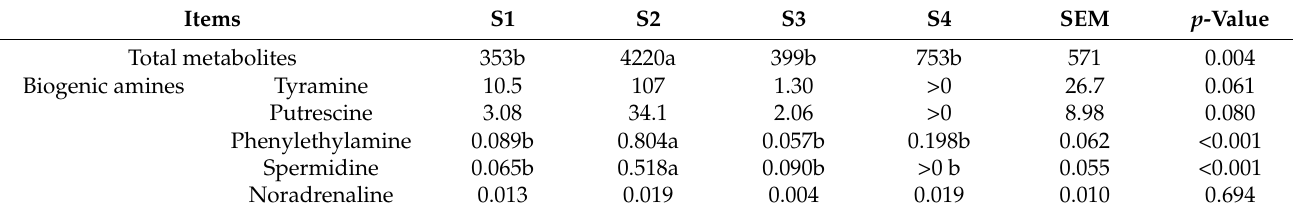
Figure 5. Principal component analysis of the metabolites in whole-plant corn silages (n = 3). S1, silage collected from Erdos; S2, silage collected from Baotou; S3, silage collected from Ulanqab; S4, silage collected from Hohhot. Table 4. Relative concentrations of total metabolites and biogenic amines in whole-plant corn silage (n = 3).